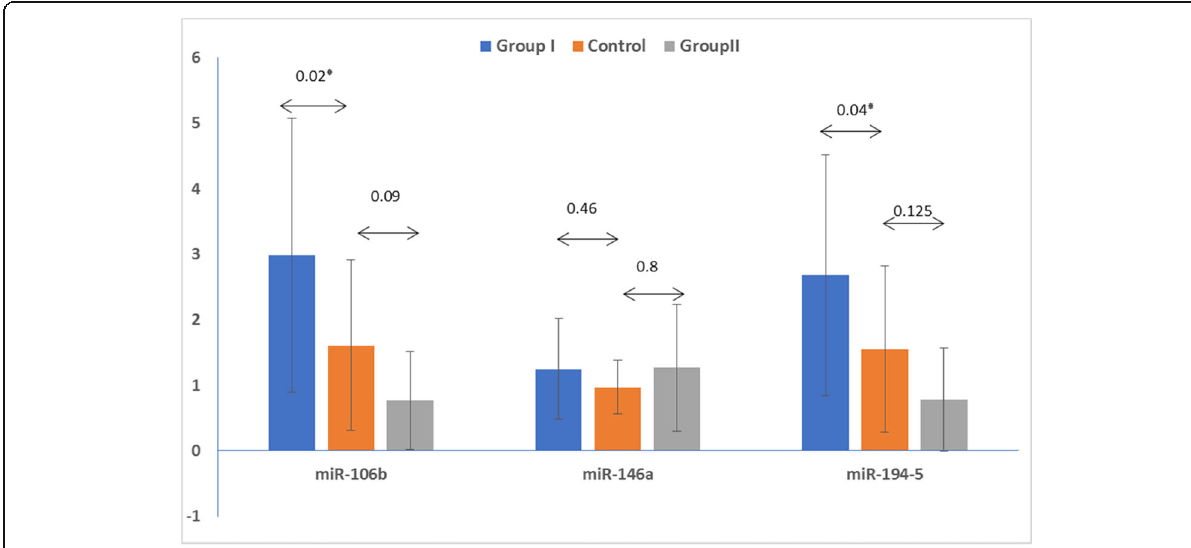
Fig. 1 Comparison between groups I and II and control as regards the expression of miR 106b, miR 146a, and miR 194-5p. *Significant p